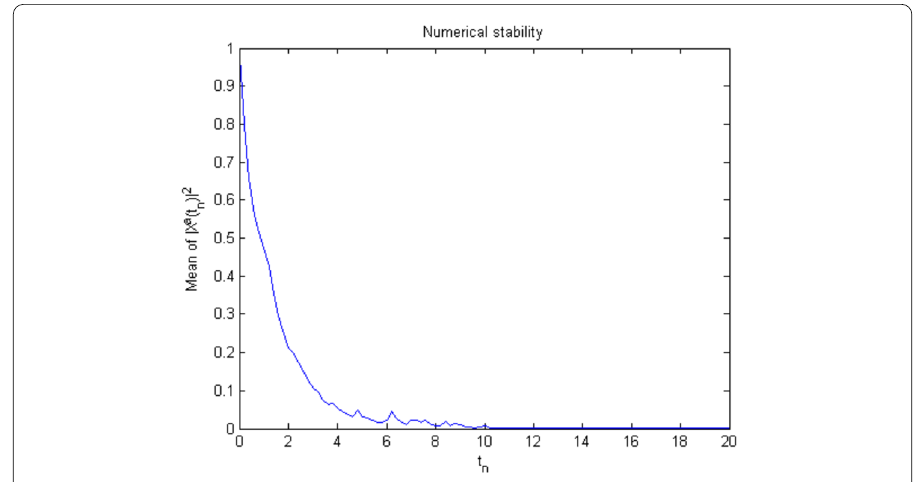
Figure 7 The average of numerical solution over 10,000 discretized Brownian paths with h = 0.2, T = 20 and c = 0.01 for Example 5.3